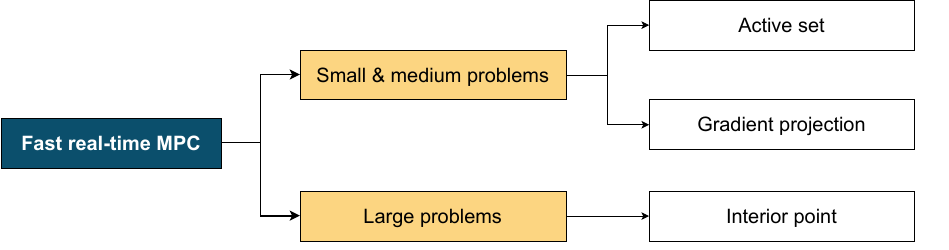
Figure 22. Recommended methods for small and large scale